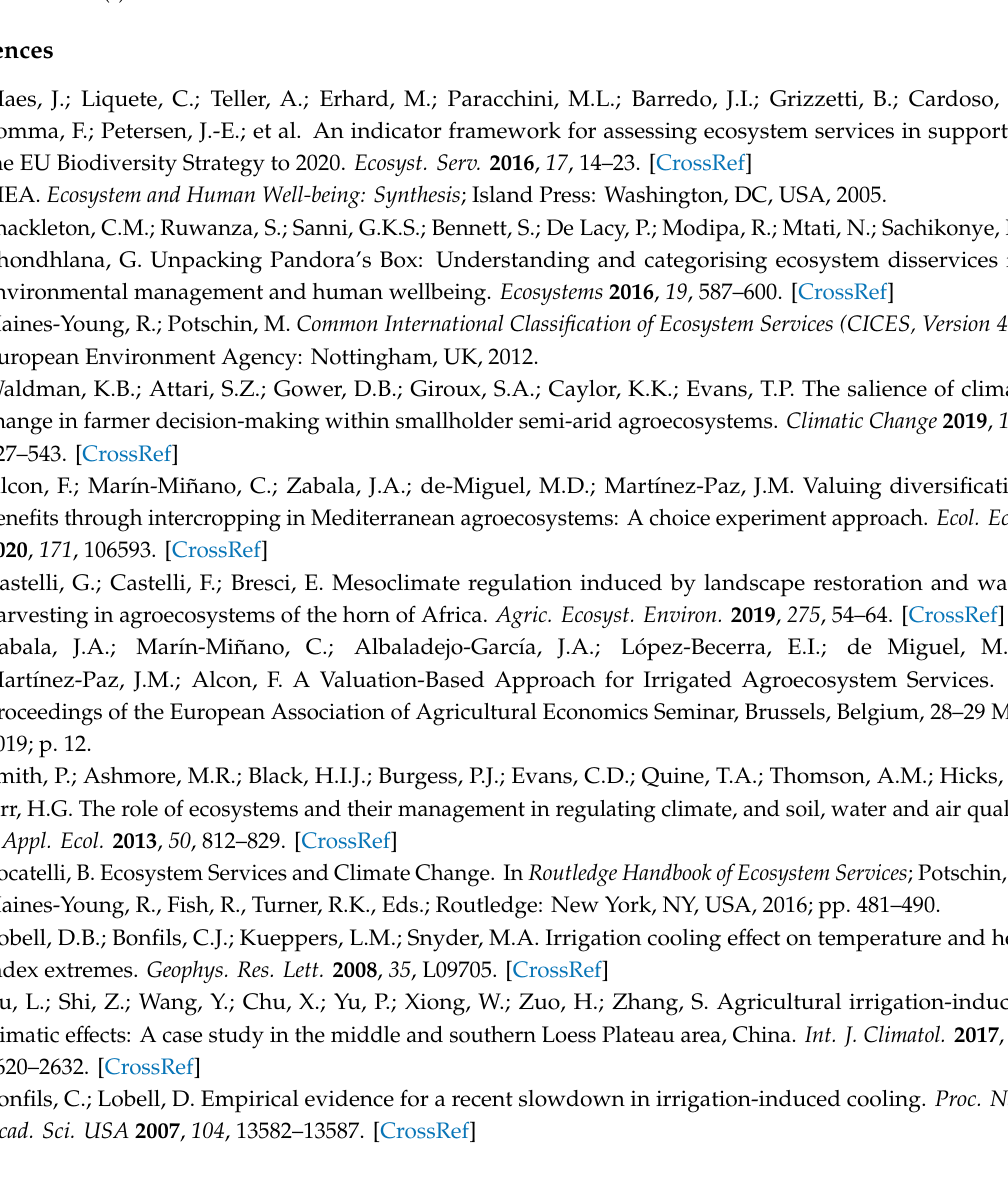
Figure A1. Spatial distribution of factors: NDVI ( a ), NDWI ( b ), Tair ( c ), Altitude ( d ), Slope ( e ), and Orientation ( f ).